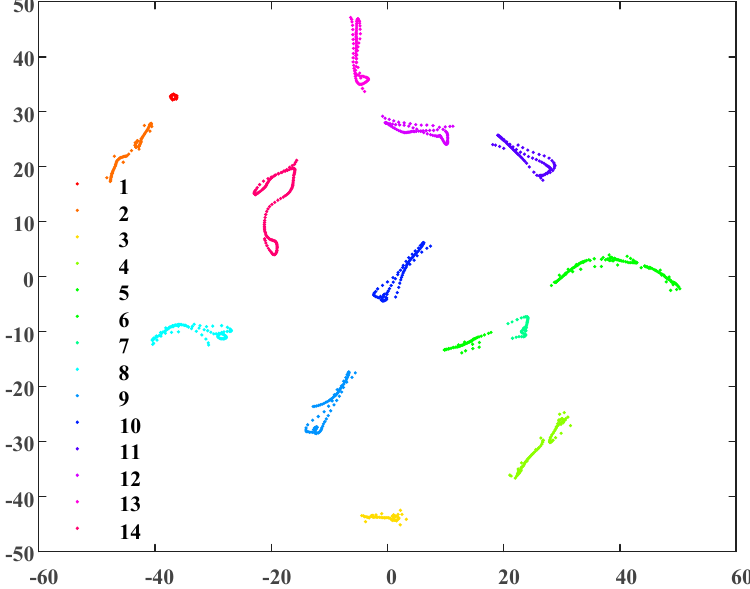
Figure 10. The DBSCAN (density-based spatial clustering of applications with noise) clustering results of the sheath current matrix V .